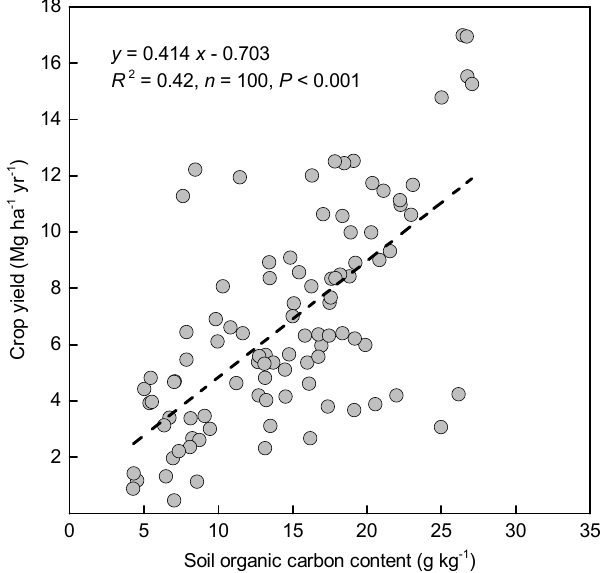
Figure 2. Relationship between crop yield and soil organic carbon content.